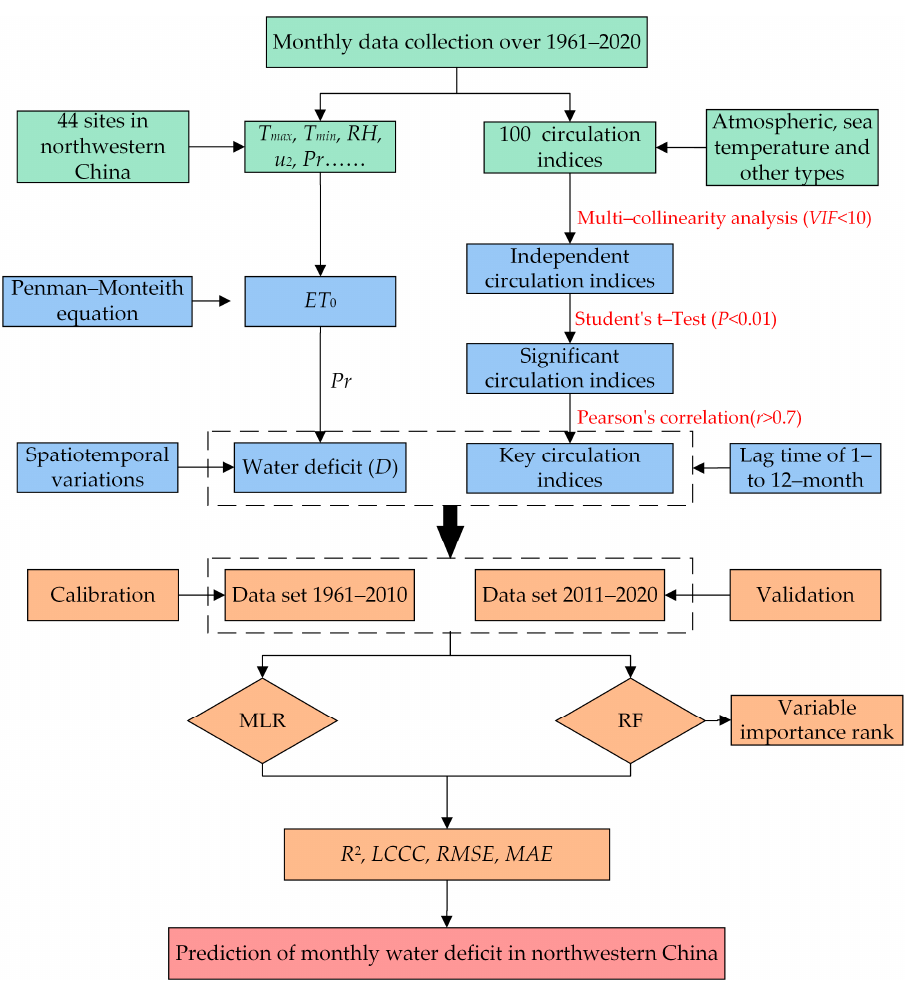
Figure 2. The overall framework of the research.